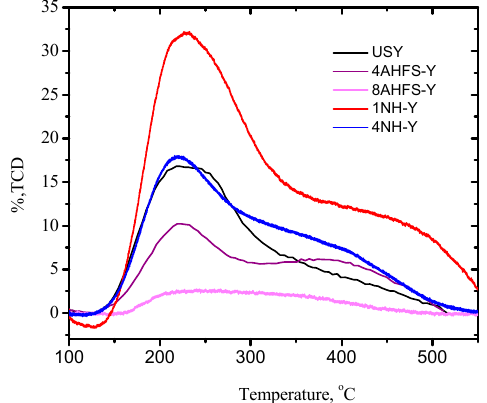
Table 1. Crystal structure parameters of modified USY.